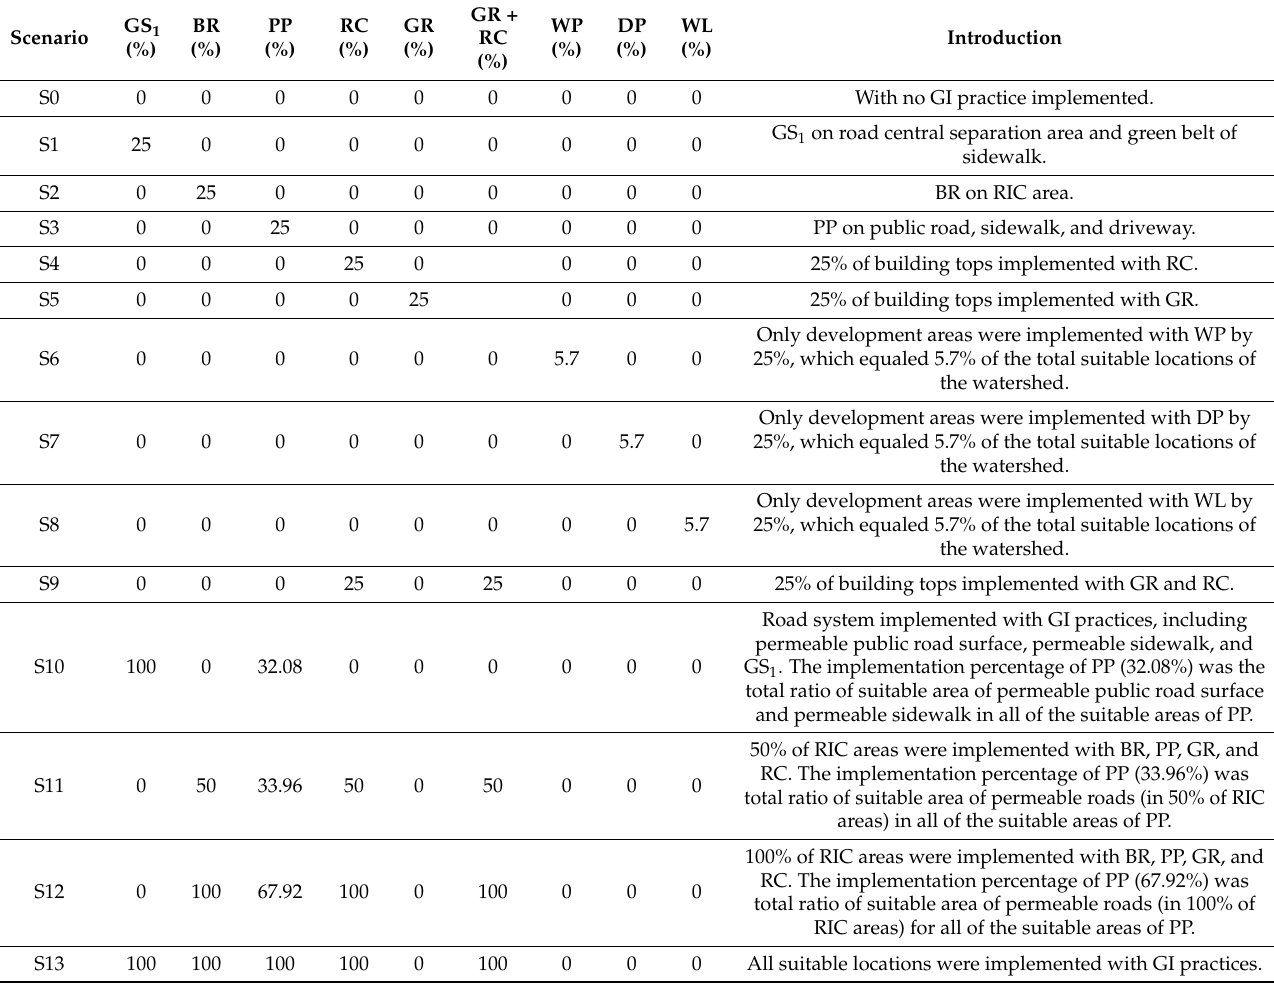
Table 3. GI practice combination in each scenario. Introduction With no GI practice implemented. GS 1 on road central separation area and green belt of sidewalk. BR on RIC area. PP on public road, sidewalk, and driveway. 0 25% of building tops implemented with RC. 25% of building tops implemented with GR. Only development areas were implemented with WP by 25%, which equaled 5.7% of the total suitable locations of the watershed. Only development areas were implemented with DP by 0 25%, which equaled 5.7% of the total suitable locations of the watershed. Only development areas were implemented with WL by 5.7 25%, which equaled 5.7% of the total suitable locations of the watershed. 25% of building tops implemented with GR and